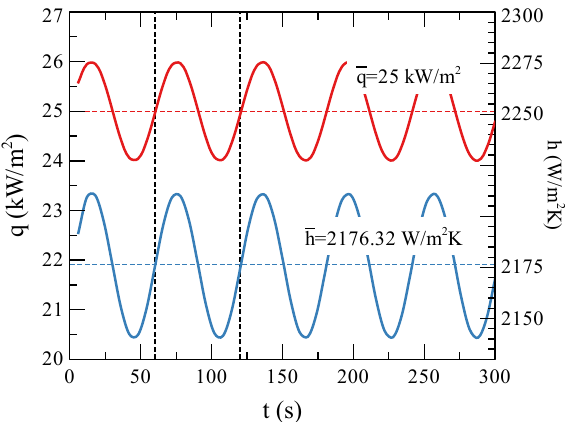
Figure 6. Time dependences of the heat flow and heat transfer coefficient for the Cauchy boundary condition with time dependence, in this case with a sine wave period of 10 s. The ratio of the amplitude and the time average value of the heat flow is 4% and the ratio of the amplitude and the time average value of the heat transfer coefficient is 3.2%. The amplitude and frequency of both values is constant and the phase delay is